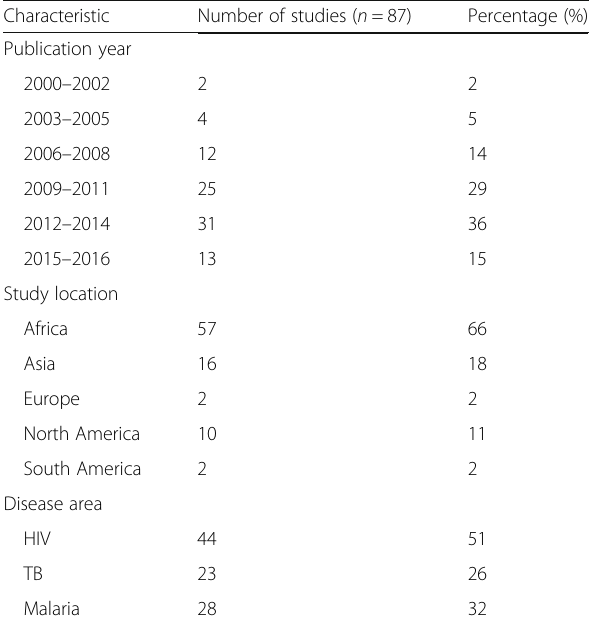
Table 4 Summary of included studies